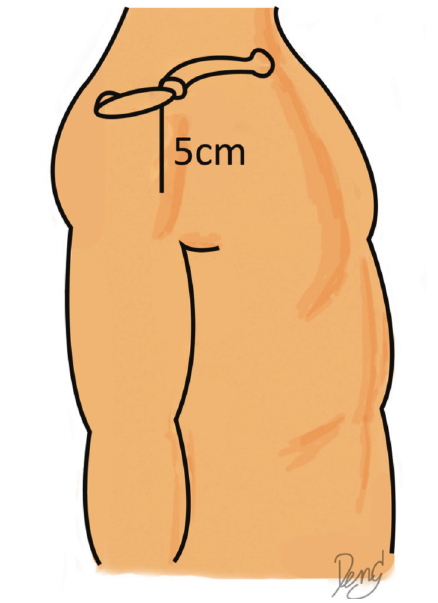
Cadaver in supine position. Bony landmarks were Fig. 1: marked. Incision was made for 5cm from tip of acromion.